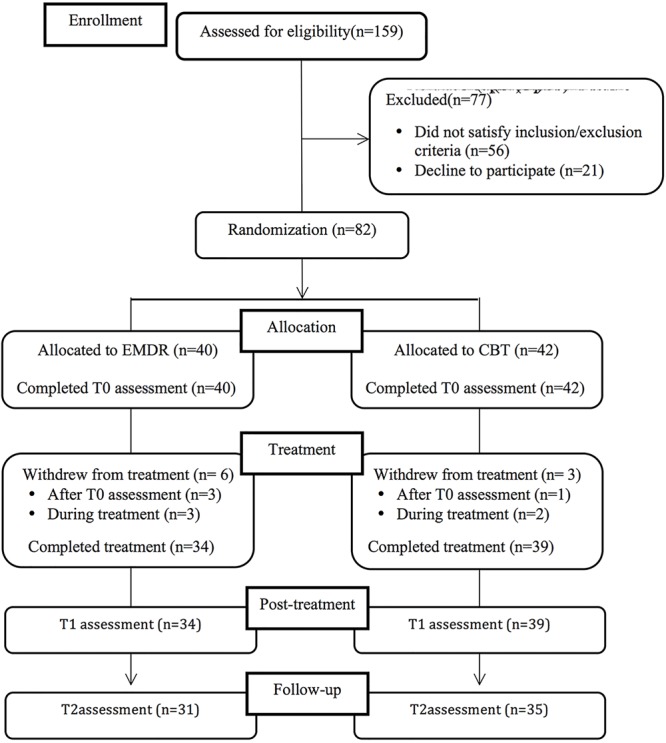
Participants flow diagram.